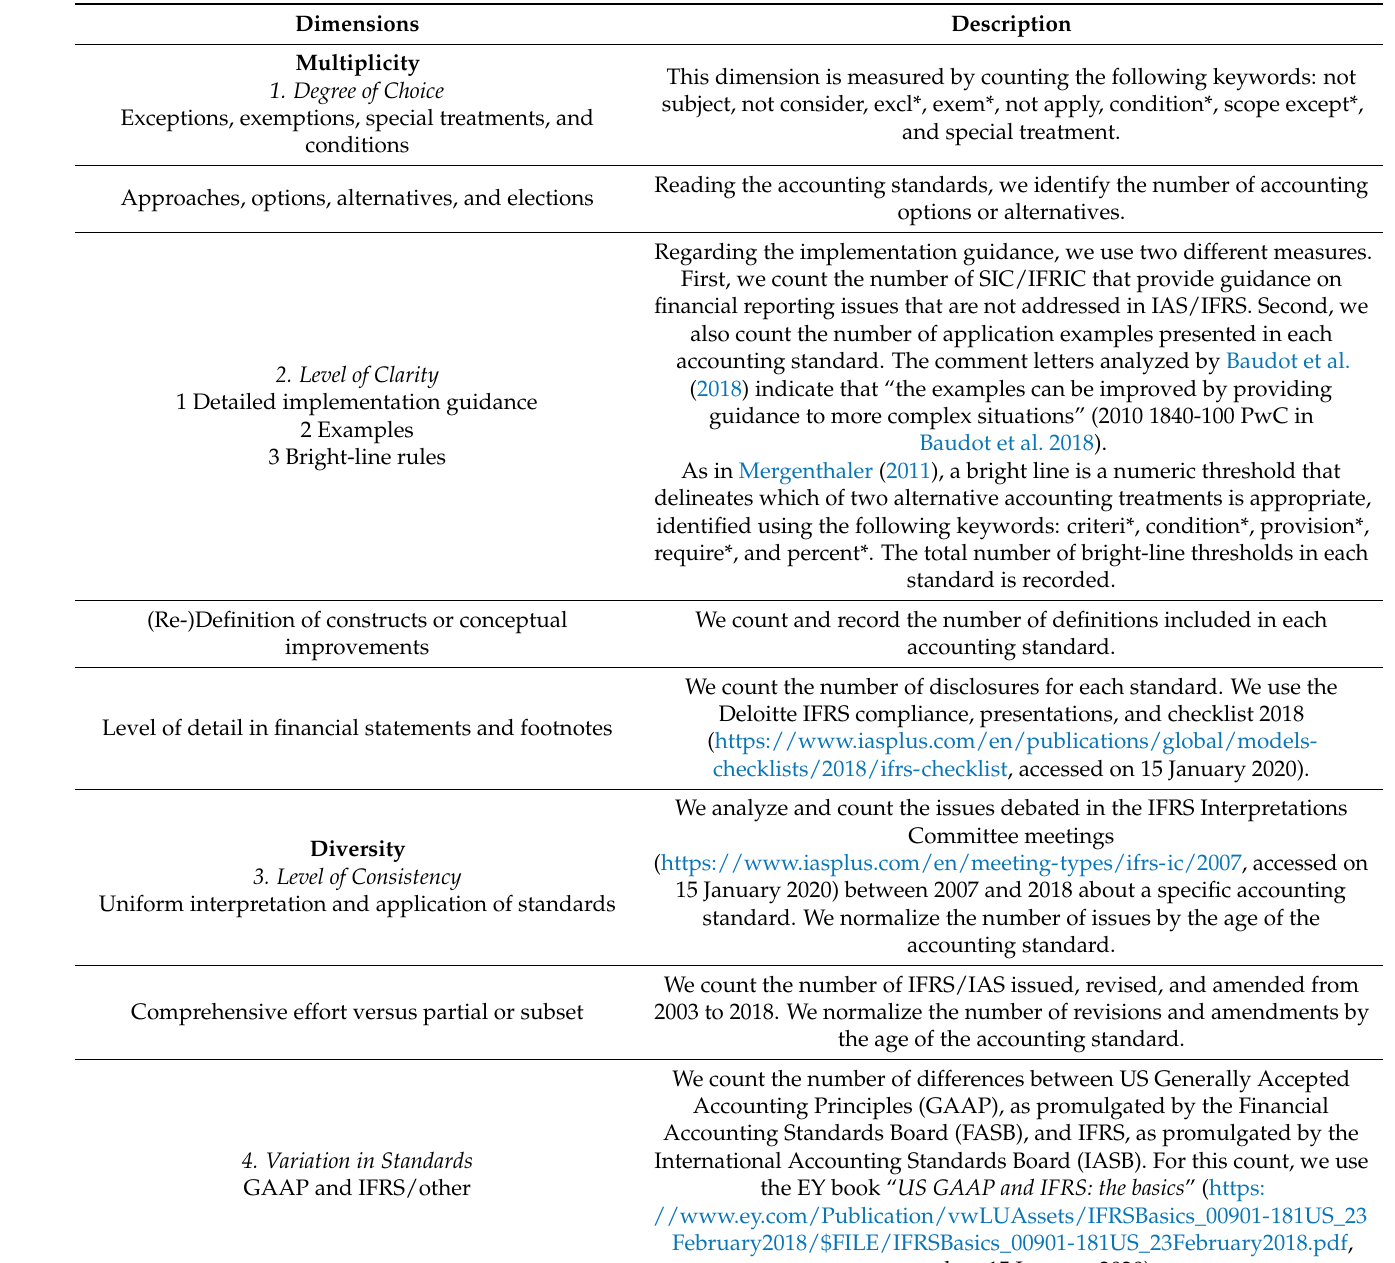
Table 1. Dimensions used in the complexity index of accounting